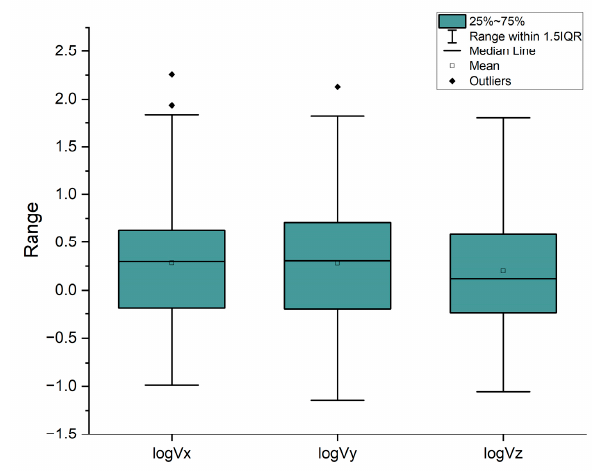
Figure 2. Box chart of three-direction vibration velocity.